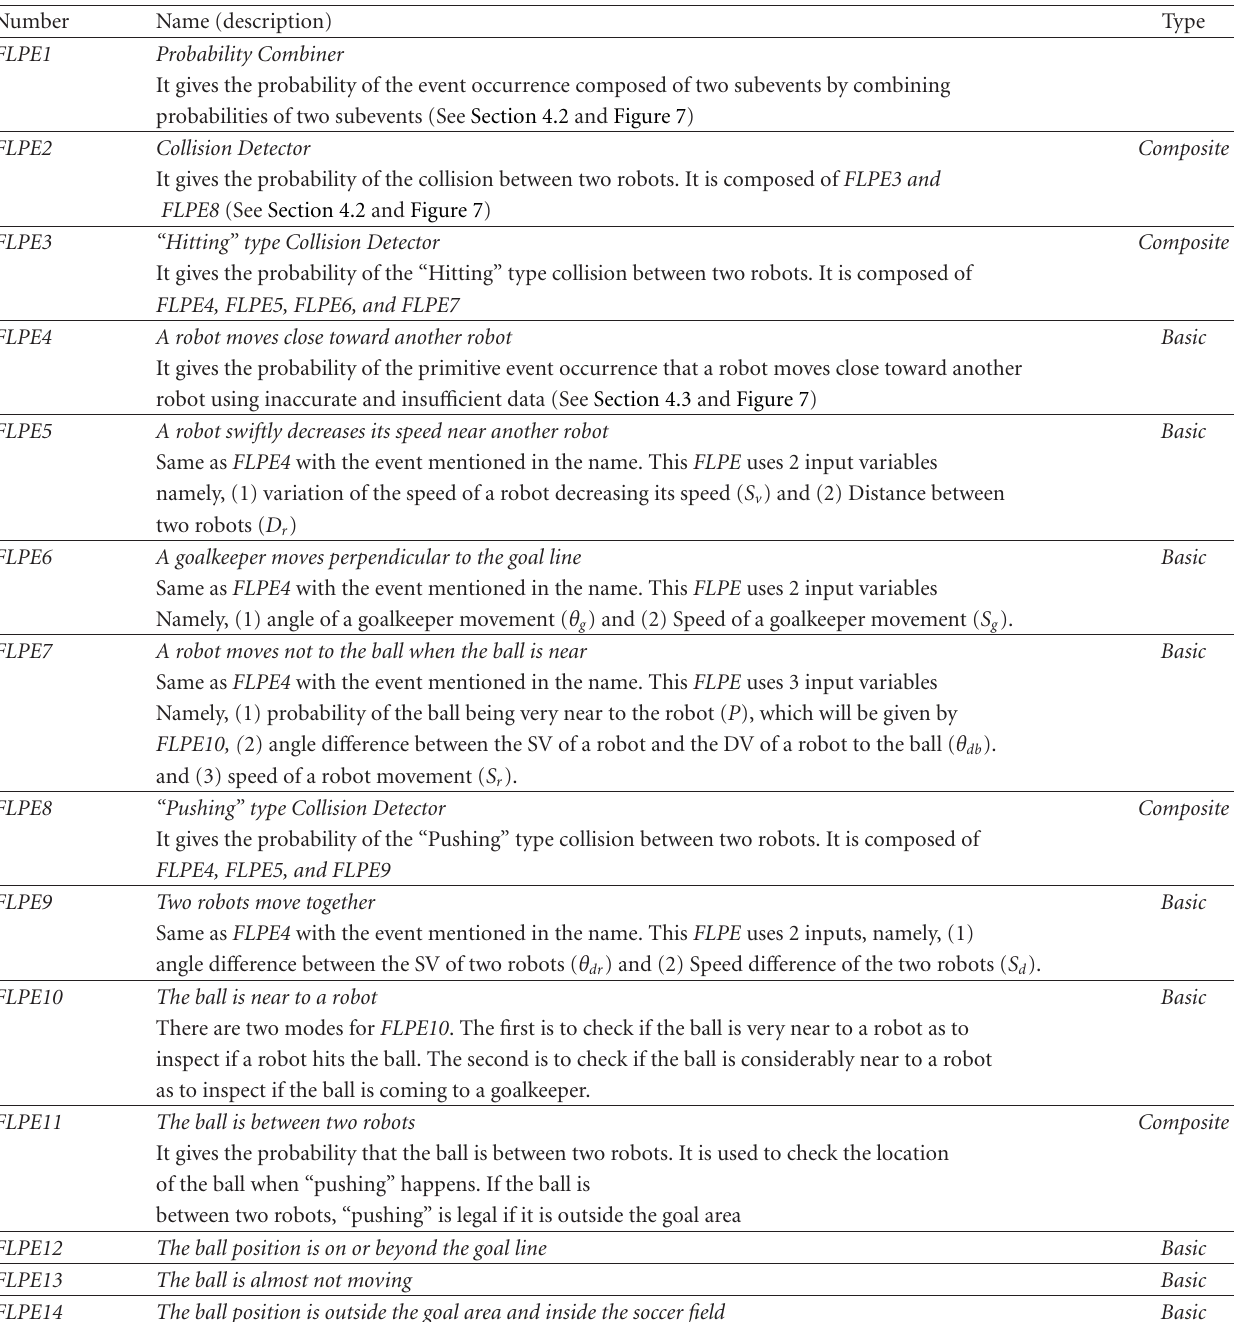
Table 2: Detail description of Fuzzy Logic Probability Evaluators